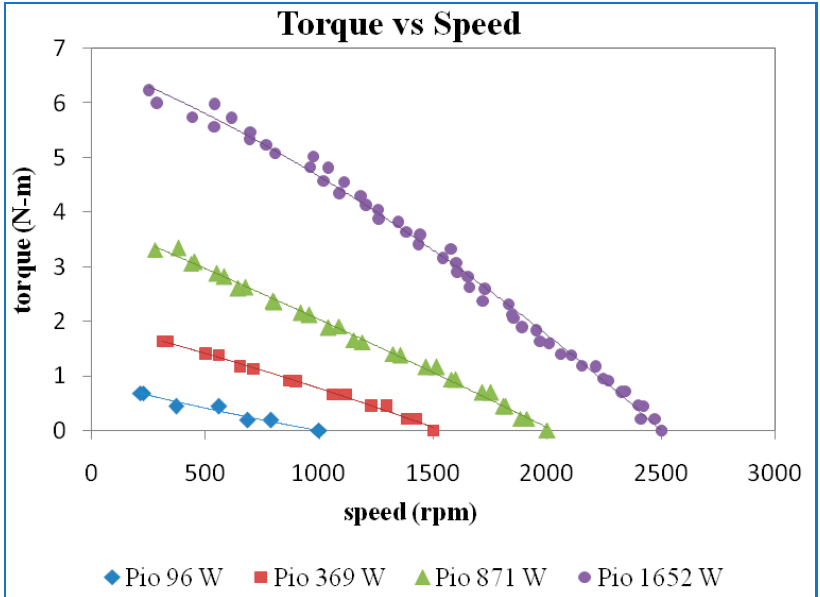
Figure 21. Torque vs. speed at a guide vane opening of 19 mm.